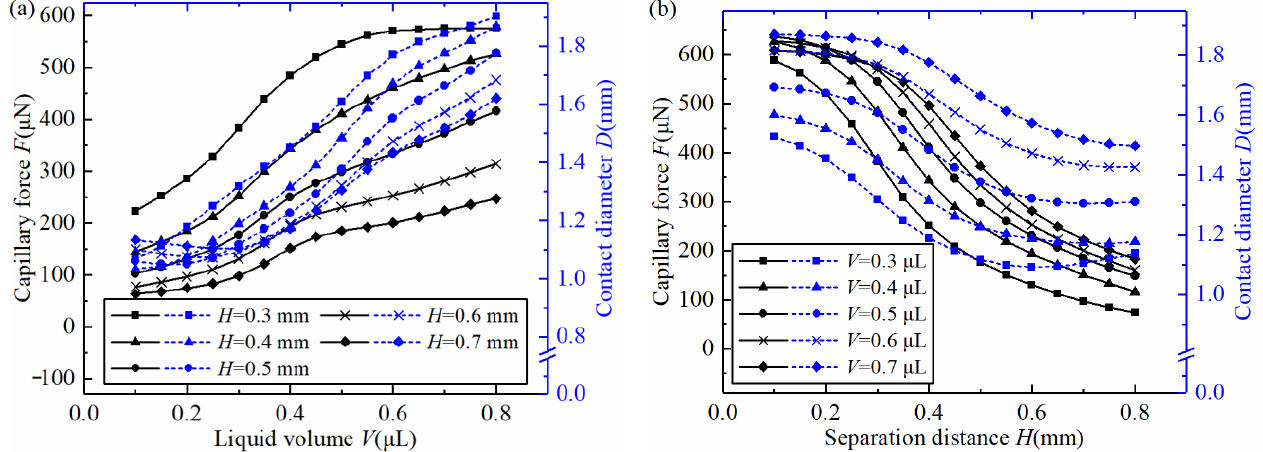
Figure 11. Capillary force and contact diameter versus input parameters: ( a ) changing V with vari- ous H ( θ = 36°, γ = 50 mN/m), ( b ) changing H with various V ( θ = 36°, γ = 50 mN/m).